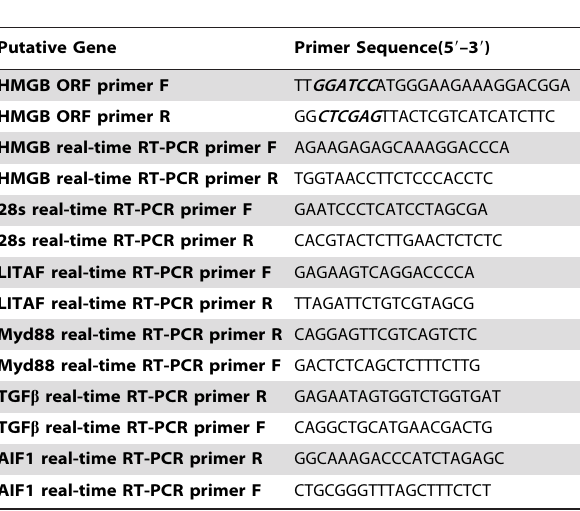
Table 1. Sequences of primer pairs used in this